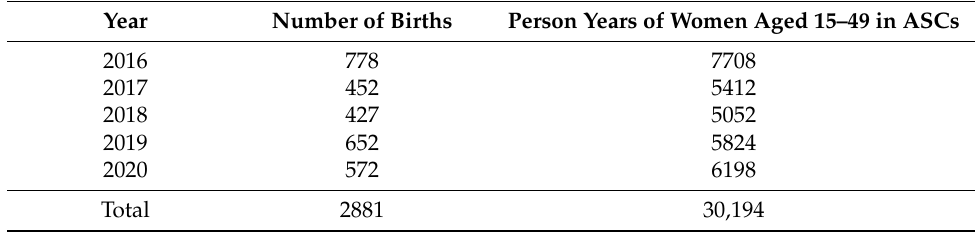
Table A1. Number of births and person years per year from 2016 to